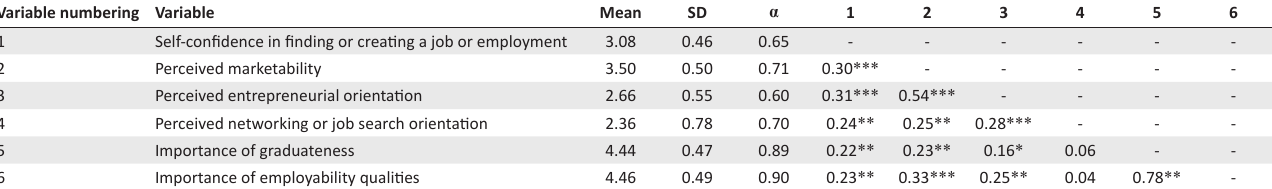
TABLE 1: Descriptive statistics and bivariate correlations ( N = 153). Variable numbering